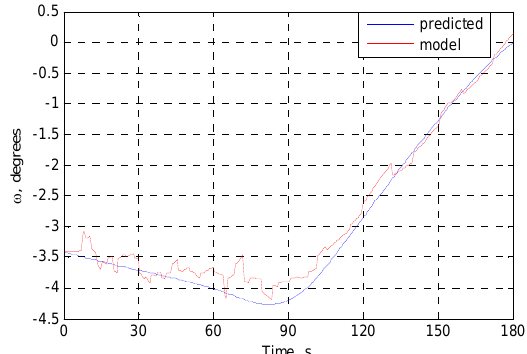
Figure 6. Recovered orientation angle